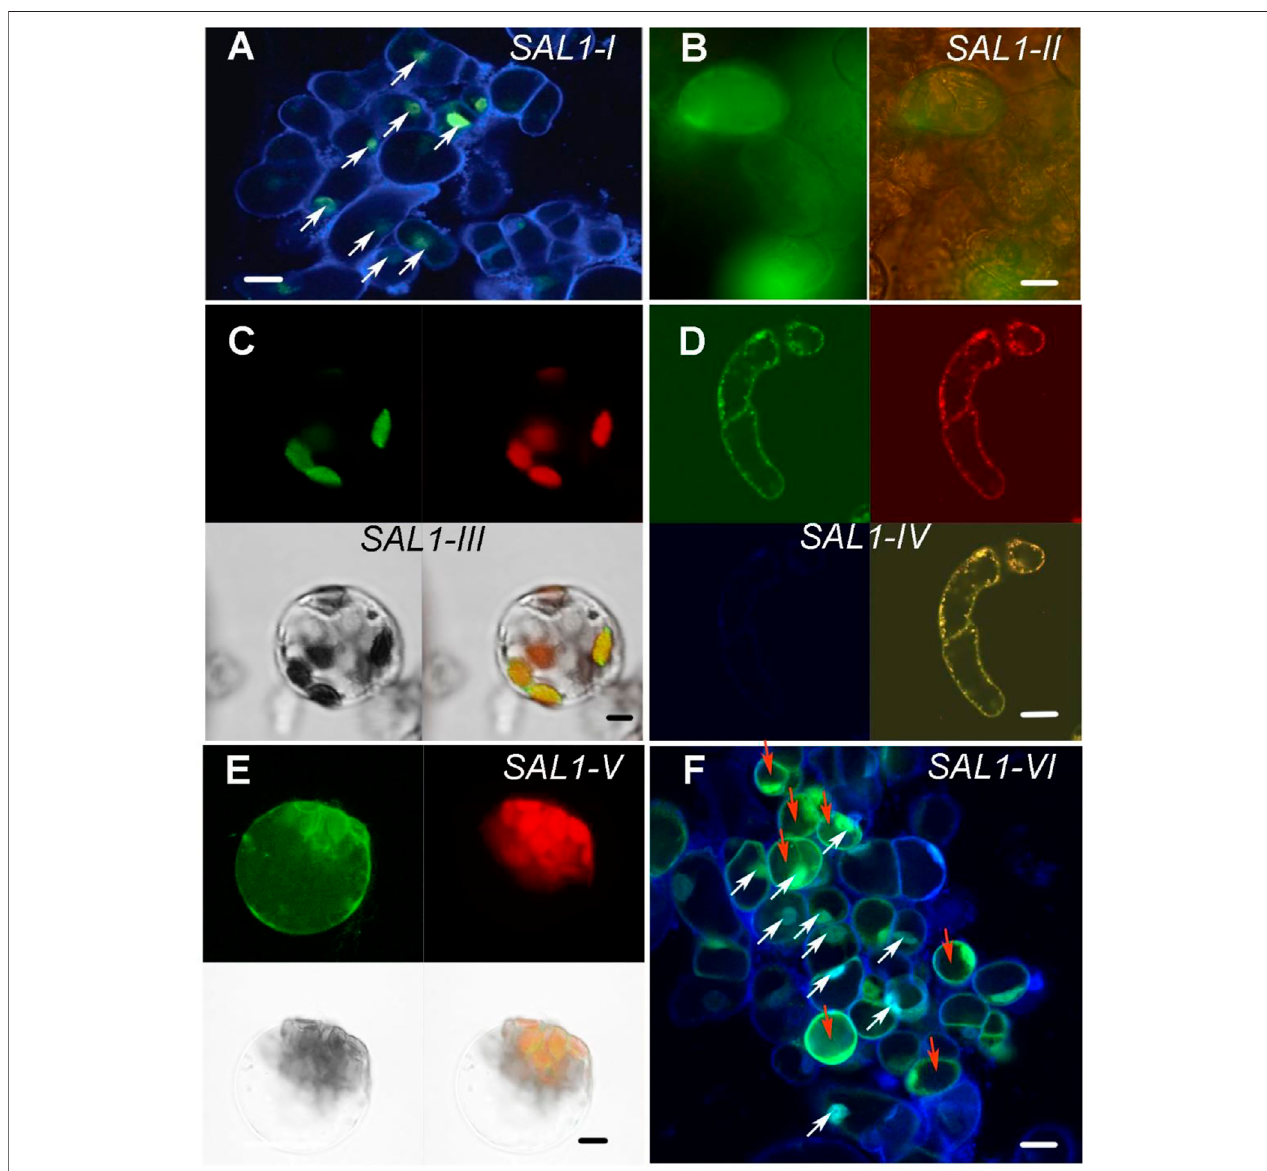
FIGURE 2 | Subcellular localization of SAL1_I – SAL1_VI proteins in Arabidopsis root cell suspension cultures, protoplasts from the mesophyll, and in Nicotiana benthamiana . Transient expression of SAL1 protein chimeras fused to green fl uorescent protein (GFP) under control of the 35S CaMV promoter in various subcellular compartments of cells from Arabidopsis root cell suspension culture, as revealed by confocal fl uorescence microscopy. (A) DAPI-stained Arabidopsis suspension cells form roots showing the nuclear localization of SAL1_I:GFP. White arrows show cells in which both GFP and DAPI are visible in thenuclei. Bar (cid:1) 20 μ m. (B) Cytosolic localization of SAL1_II:GFP shown with GFP fi lter and bright fi eld and GFP. Bar (cid:1) 40 μ m. (C) Chloroplasticlocalization of SAL1_III:GFP in Arabidopsis protoplasts form the mesophyll four fi elds with GFP, chlorophyll auto fl uorescence, bright fi eld, and overlay of GFP and chlorophyll signals. Bar (cid:1) 10 μ m. (D) Mitochondrial localization of SAL1_IV:GFP in Arabidopsis suspension cells form roots four fi elds with GFP, MitoTracer in red , DAPI staining, and overlay of both MitoTracker with GFP. Bar (cid:1) 20 μ m. (E) SAL1_V:GFP localization in Arabidopsis protoplasts form the mesophyll. It shows the presence of SAL1 in chloroplasts and in some tiny dot-like structures in the cytosol, which can be the mitochondria. Four fi elds show GFP, chlorophyll auto fl uorescence, bright fi eld, and overlay of GFP and chlorophyll signals. Bar (cid:1) 10 μ m. (F) DAPI-stained Arabidopsis suspension cells form roots , showing both the cytosolic and nuclear localization of GFP. White arrows show cells in which both GFP and DAPI are visible in the nuclei. Red arrows show cells in which GFP is visible in the cytosol. Bars (cid:1) 20 μ m.